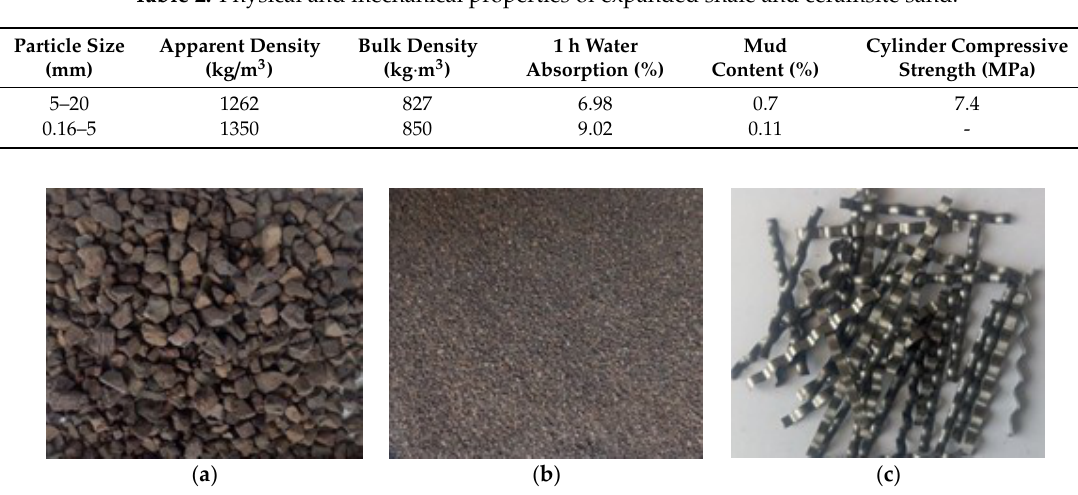
Table 2. Physical and mechanical properties of expanded shale and ceramsite sand.